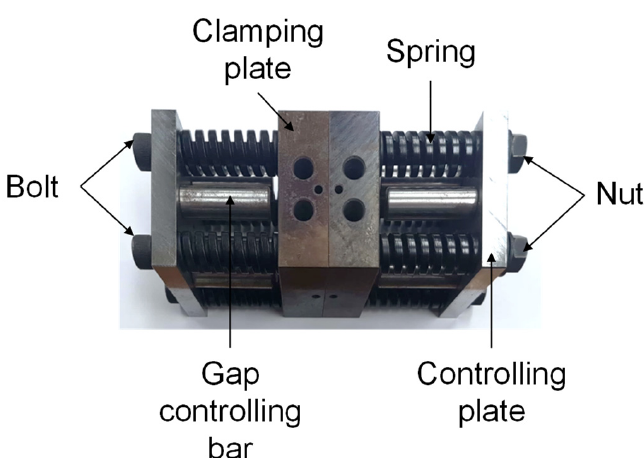
Figure 2. Pre-drilled clamp set for controlling the temperature of the material.